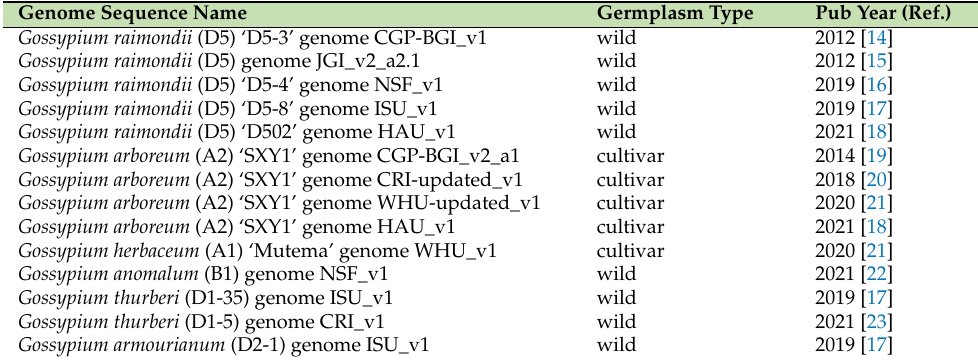
Table 2. List of 30 diploid genome sequences available in CottonGen (by 31 August